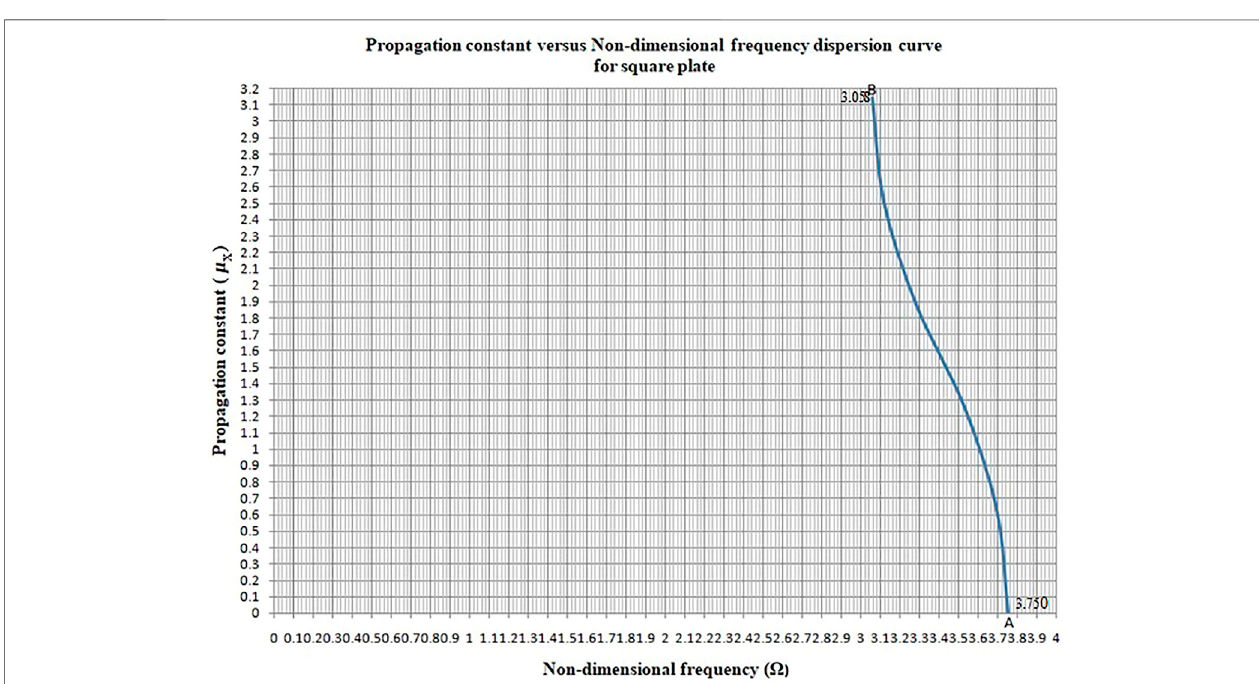
FIGURE 11 | Propagation band A-B (at A, Ω = 3.750 and μ x = 0; at B, Ω = 3.058 and μ x = π (3.142)) of the propagation surface ( Figure 6 ) of the periodic square plate using present